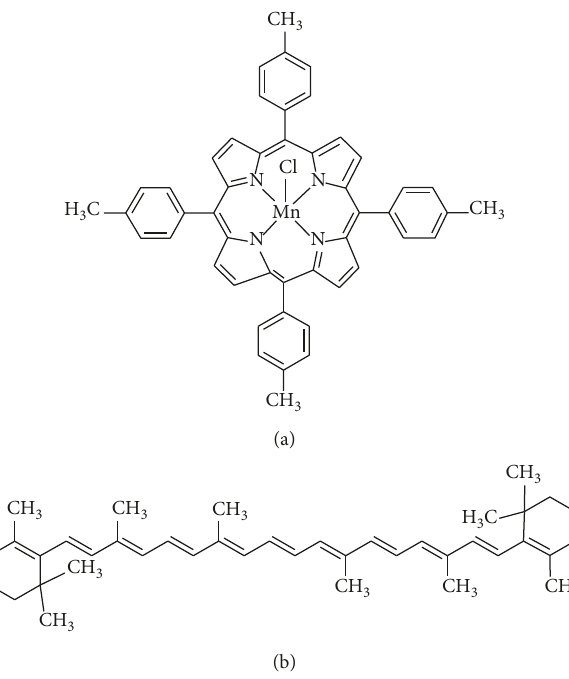
Figure 1: Structure of chloro[5,10,15,20-tetrakis-(4-methylphenyl) porphyrinato manganese(III)] ( MnTTPCl ) (a) and β -carotene